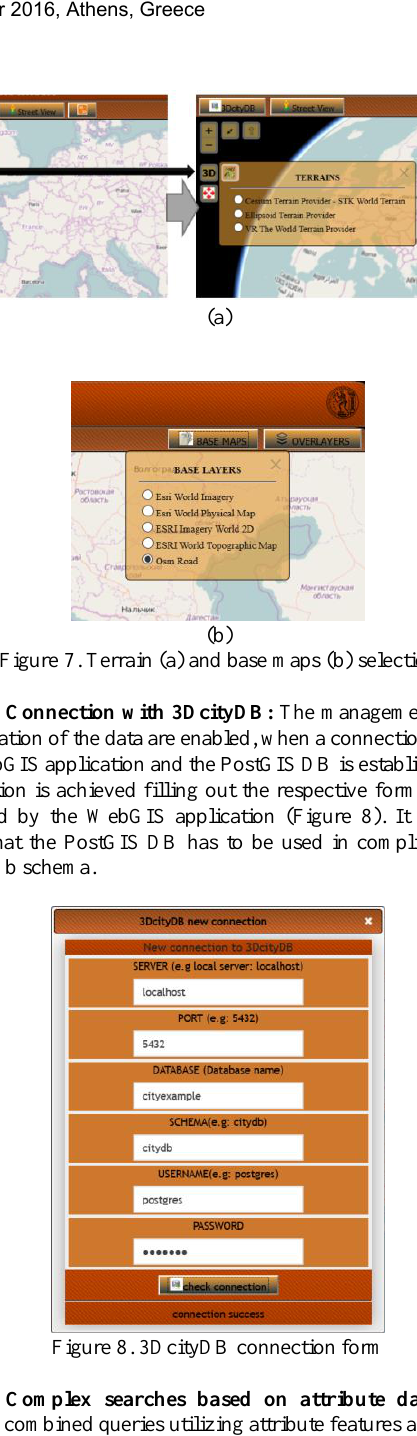
Figure 6. SQL query